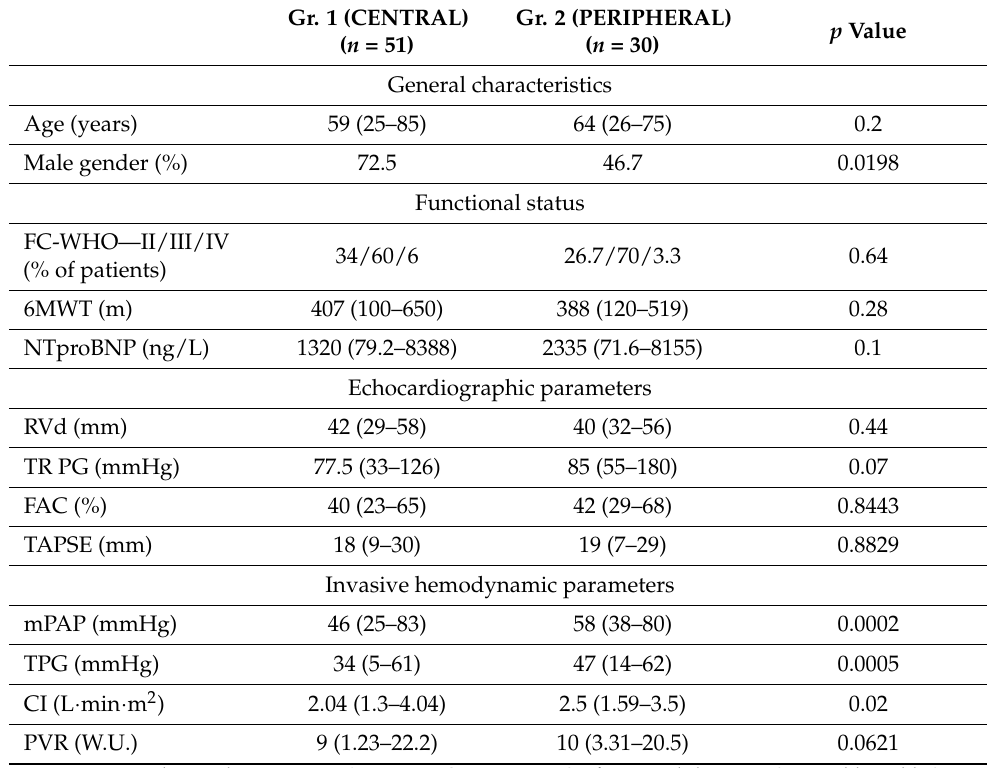
Table 1. Clinical and hemodynamic characteristics—Group 1 vs. Group